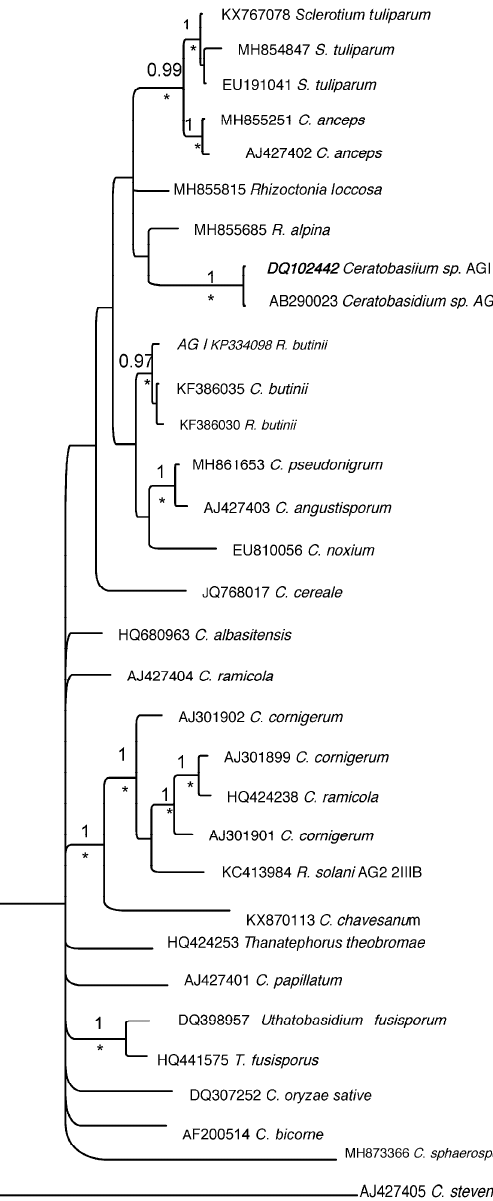
Figure 6. Bayesian tree obtained based on internal transcribed spacer sequences illustrating phylogeny of Rhizoctonia tuliparum within closely related species. One million generations with 25% of the initial trees discarded in the burn-in phase were used for analysis. Posterior probabilities >0.95 are shown above the branches. The tree was rooted with two isolates of Waitea circinata . The symbol (*) under branches indicates bootstrap support ≥ 70% obtained from parsimony analysis.